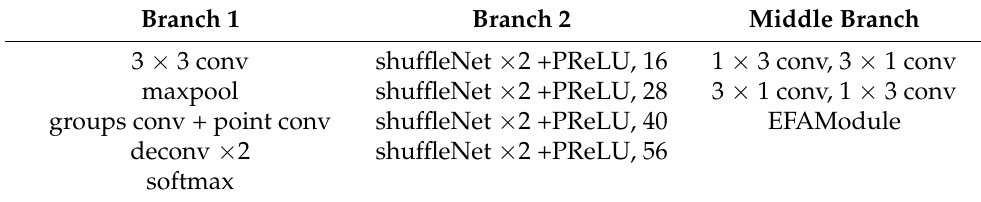
Table 1. Hidden units in each graph convolutional